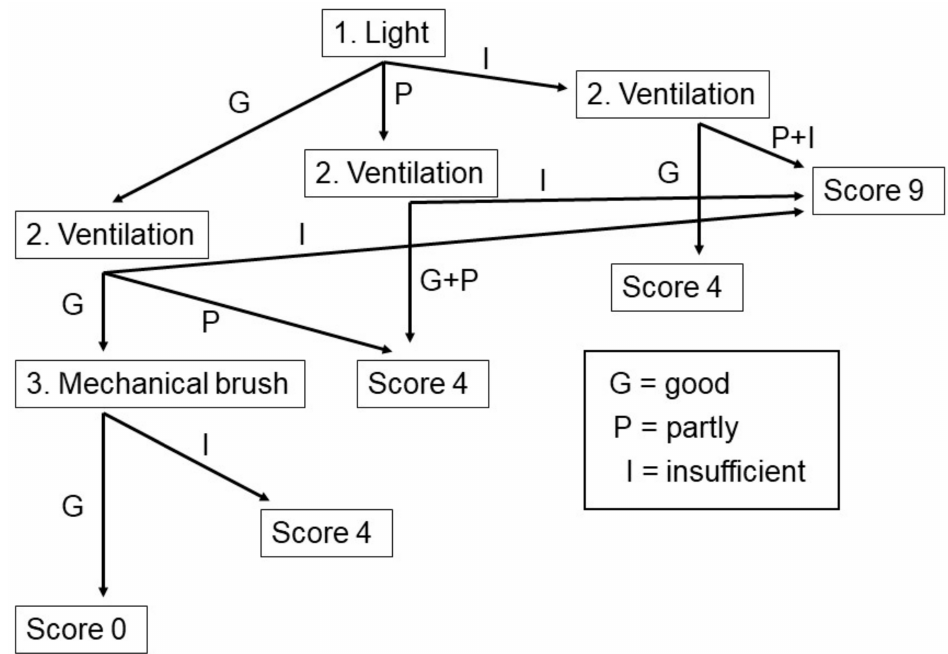
Figure 2. Flowchart for the scoring of the barn